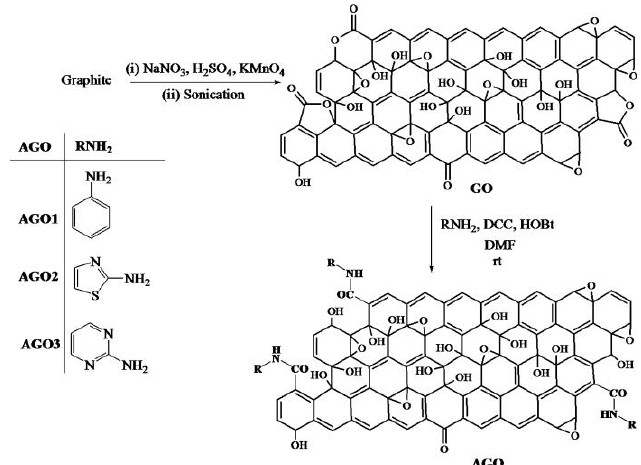
Figure 2. Schematic processing steps for the preparation of amide-functionalized graphene oxides AGO1, AGO2, and AGO3 [61]. (Reproduced from [61] with permission; Copyright 2014 Elsevier). GO: graphene oxide; AGO: amide-functionalized graphene oxide.